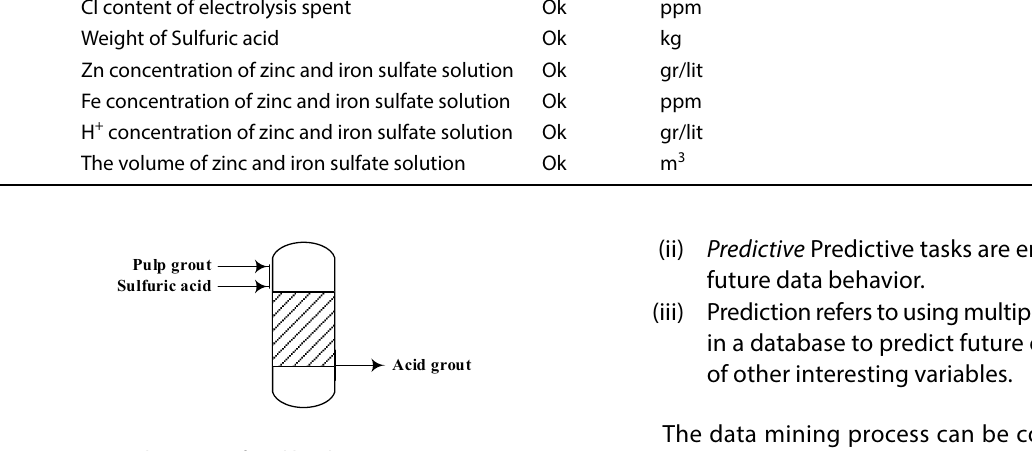
Fig. 3 Inputs and outputs of acid leaching Table 4 The input and output variables of acid leaching and their measurement status